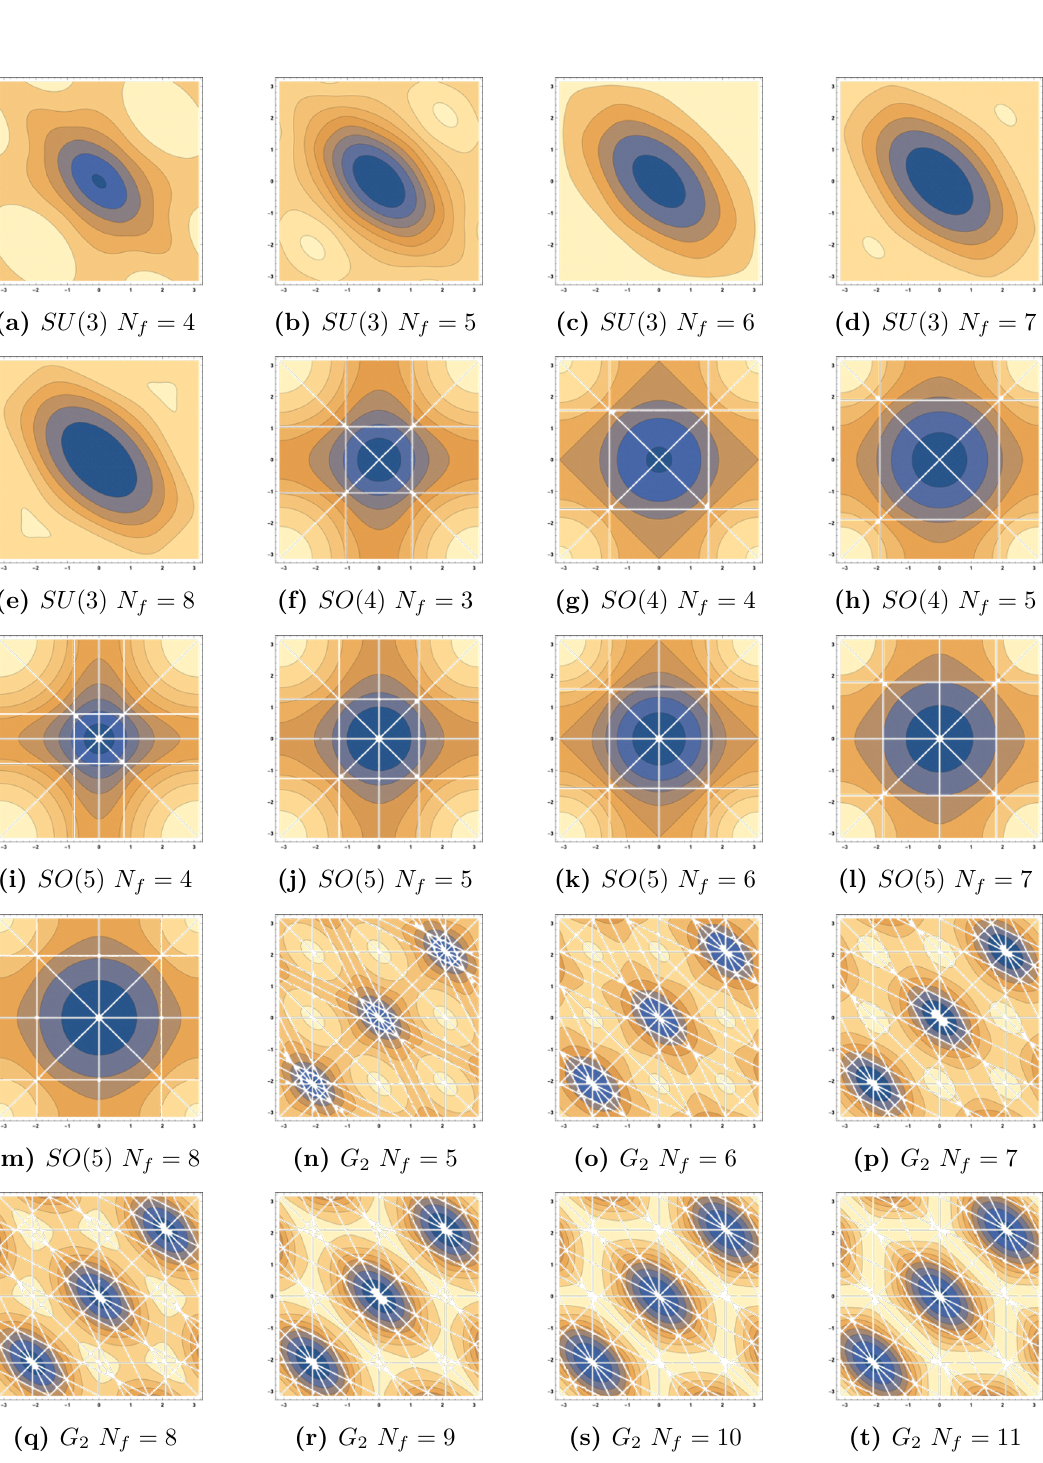
− F N f = (const). The white Sp (2) SO (5)